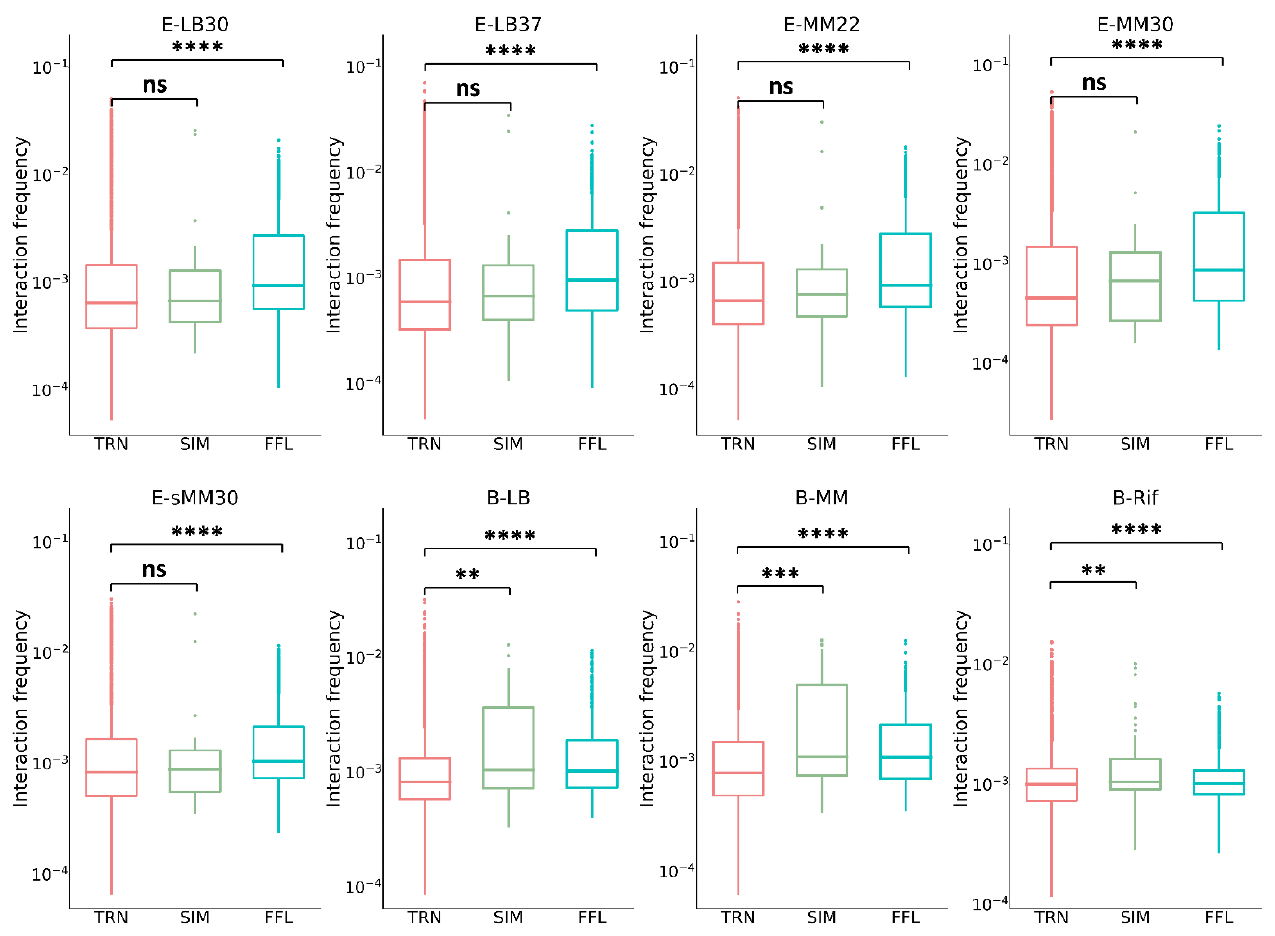
Figure 3. Comparison of chromatin interaction frequencies in network motifs with TRN. Under the five culture conditions of E. coli , the chromatin interaction frequency of FFL is significantly higher than that of TRN and that of SIM is of no significant difference from TRN. In B. subtilis , the chromatin interaction frequencies of both kinds of network motifs are significantly higher than that of TRN. The symbols on the figure indicate statistical significance levels: ns: p > 0.05; **: p ≤ 0.01; ***: p ≤ 0.001; ****: p ≤ 0.0001.